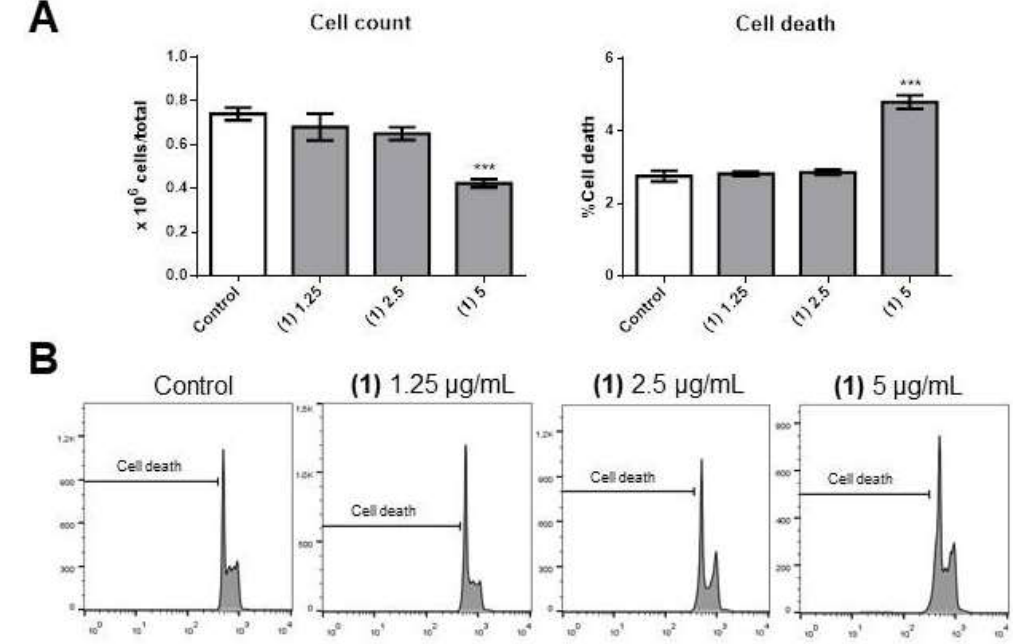
Figure 2. Effects of compound 1 on OCI-AML3 cell number and apoptotic cell death. ( A ) Bars represent the cell number (left panel) or the percentage of apoptotic cells after 24 h of treatment with control vehicle (Control) or 1,25 [(1) 1.25)], 2,5 [(1) 2.5] or 5 [(1) 5] µg/mL of compound 1 . ( B ) Flow cytometry analyses of a representative experiment. Data from three independent experiments are reported as mean ± SEM. *** p < 0.001.